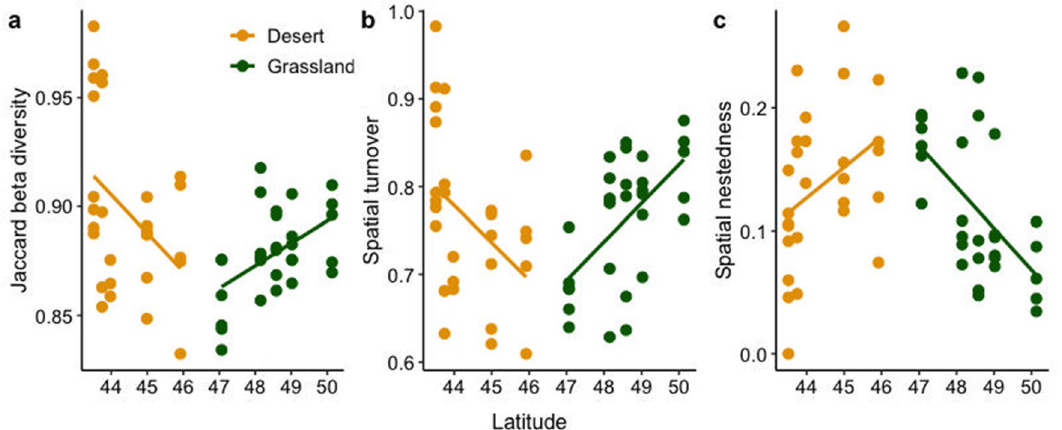
Figure 6. Beta diversity measures along the latitudinal gradient: ( a ) Jaccard’s beta diversity along latitude, ( b ) spatial turnover along latitudinal gradient and ( c ) spatial nestedness along latitude. Desert sites (1–5), grassland sites